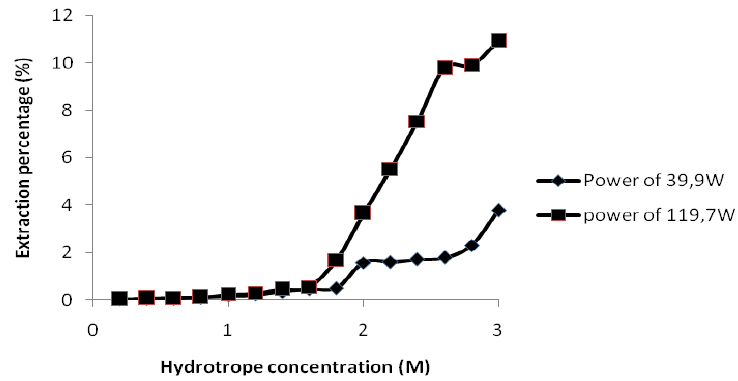
Figure 2. The effect of sodium benzoate concentration toward the percentage of andrographolide extraction.